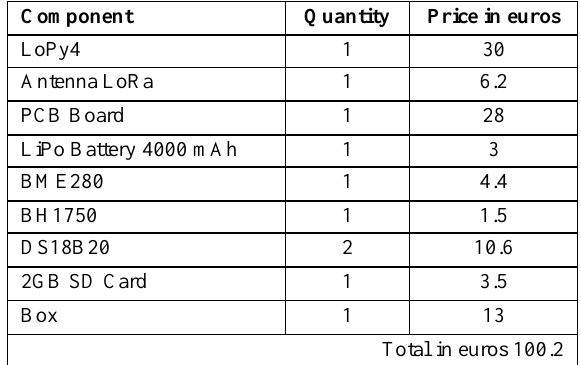
Table 2. Approximate costs of a single node/device.